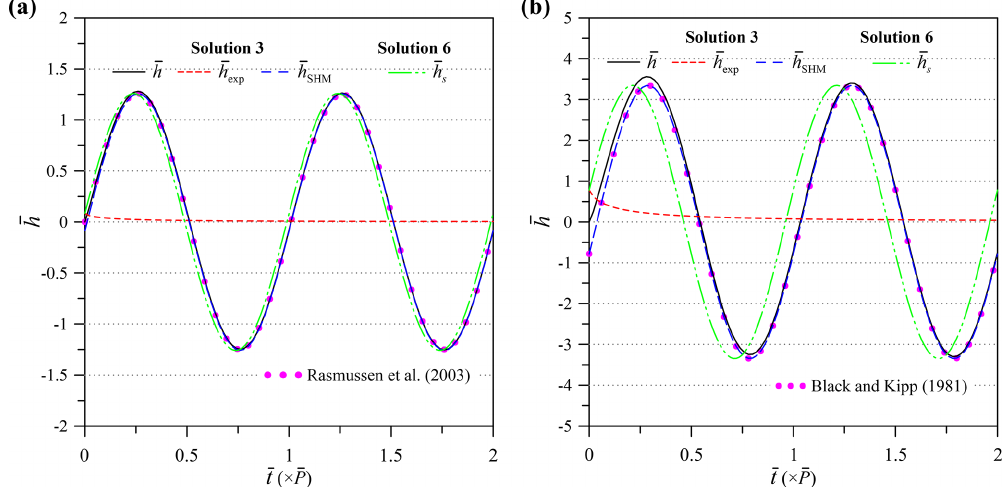
Figure 6. Head fluctuations at r = 6 predicted by Solutions 3 and 6 for (a) partially screened pumping well and (b) fully screened pumping well. Solution 3 is expressed as h = h exp + h SHM for transient flow. Solution 6, expressed as h s = A s cos (γt − φ s ) , accounts for PSS flow.